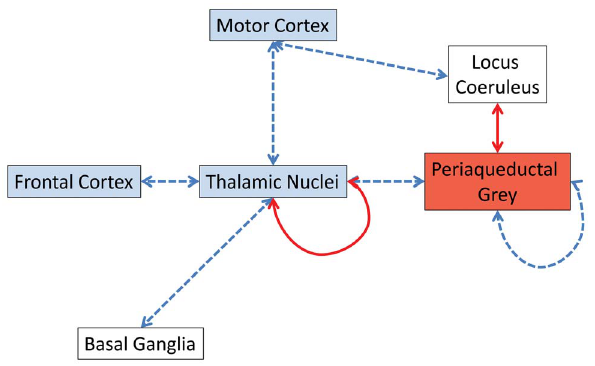
Figure 7. Summary diagram of alterations in brain system functional connectivity and overt alterations in regional cerebral glucose metabolism seen in Myk / + mice. Blue shading of neural systems indicates a significant decrease in overt cerebral metabolism while red denotes a significant increase in overt cerebral metabolism (Figure 4). Blue/broken arrows indicate a decrease in functional connectivity between and within (periaqueductal grey subfields) neural systems in Myk / + mice relative to + / + littermates. Red/ solid arrows indicate increased functional connectivity between and within (thalamic nuclei) neural systems in Myk / + mice relative to + / + littermates.